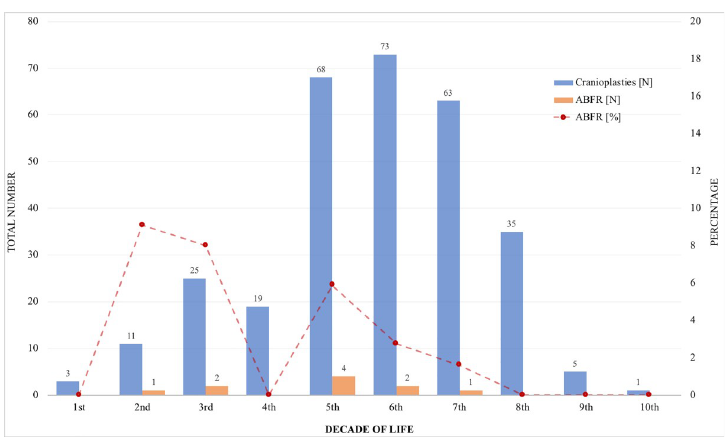
Fig 2. Absolute and relative number of ABFR in relation to decade of